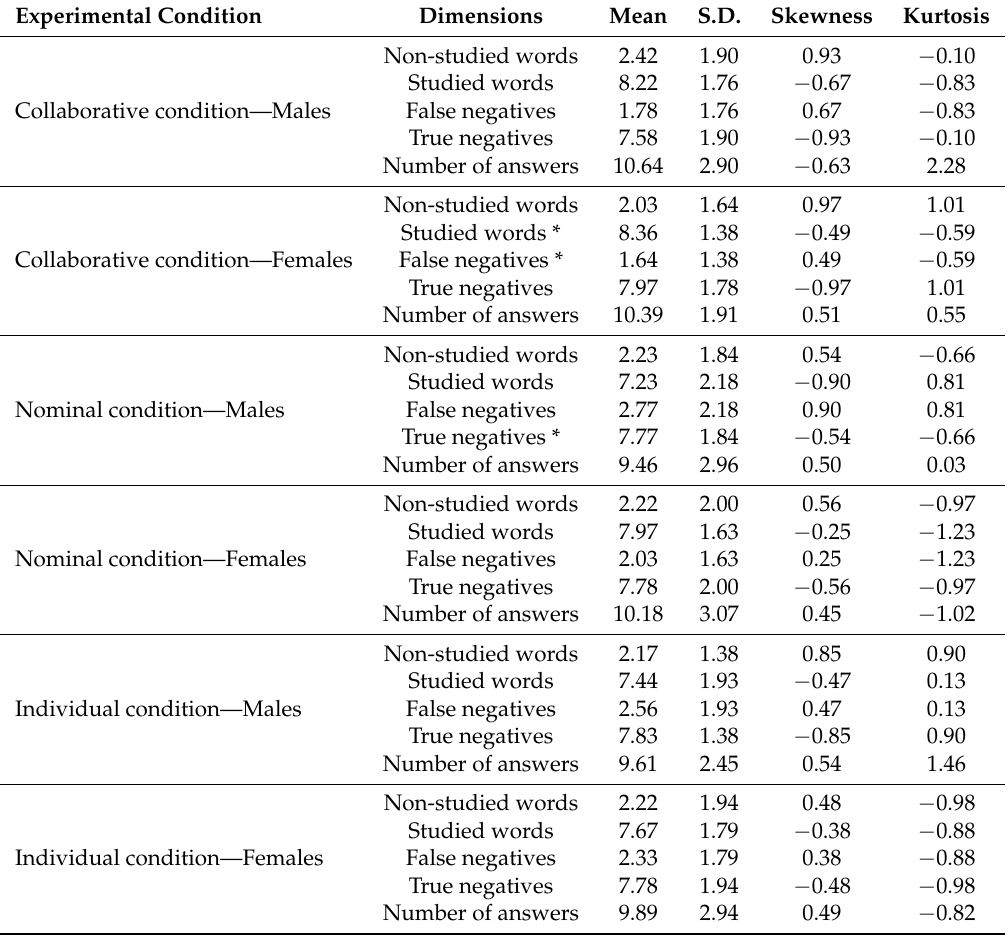
Table 2. Descriptive statistics of the subsamples. The variables reporting a skewness and kurtosis greater than 1 or smaller than − 1 (*), have been normalized by means of a logarithmic transformation. Experimental